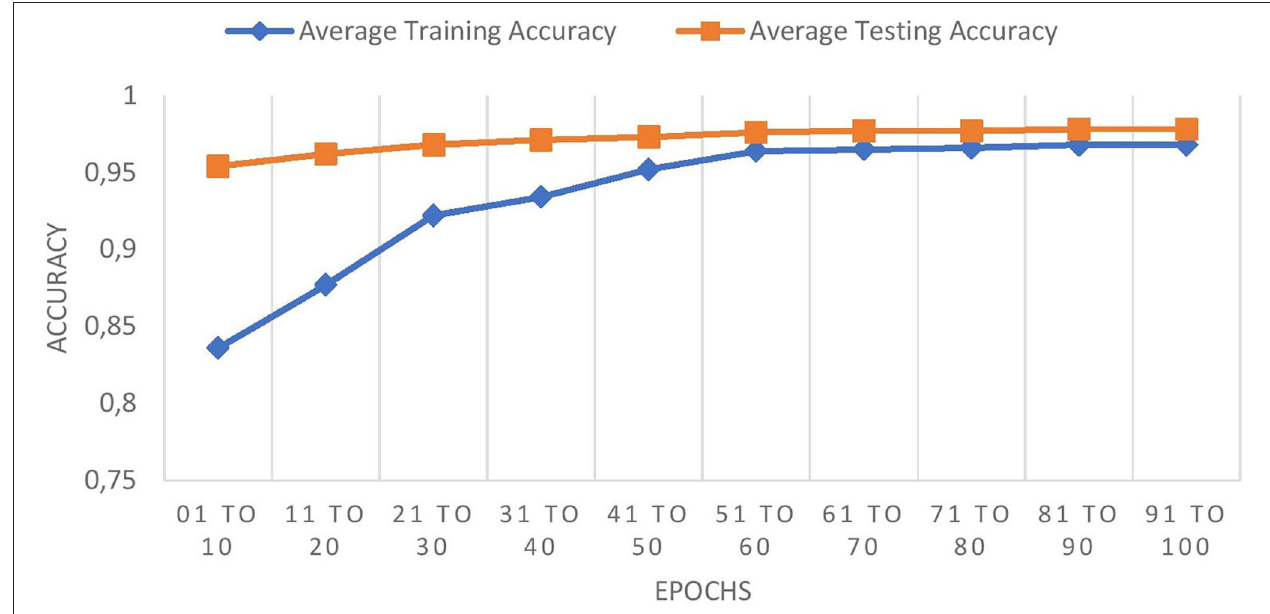
FIGURE 8 | Comparison of training and testing